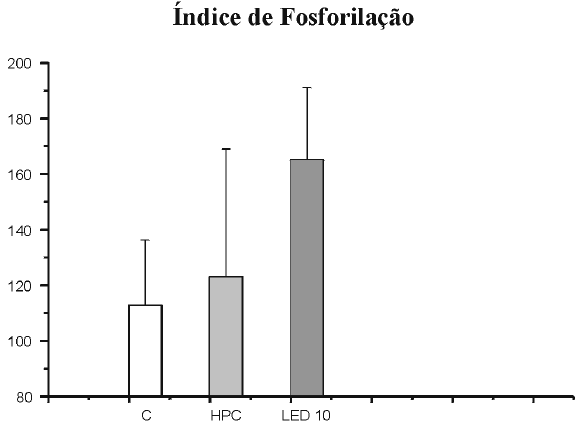
Figure 1 - Phosphorylation Index in the groups Control (C ), Partial Hepatectomy- control (HPC) and HPC and